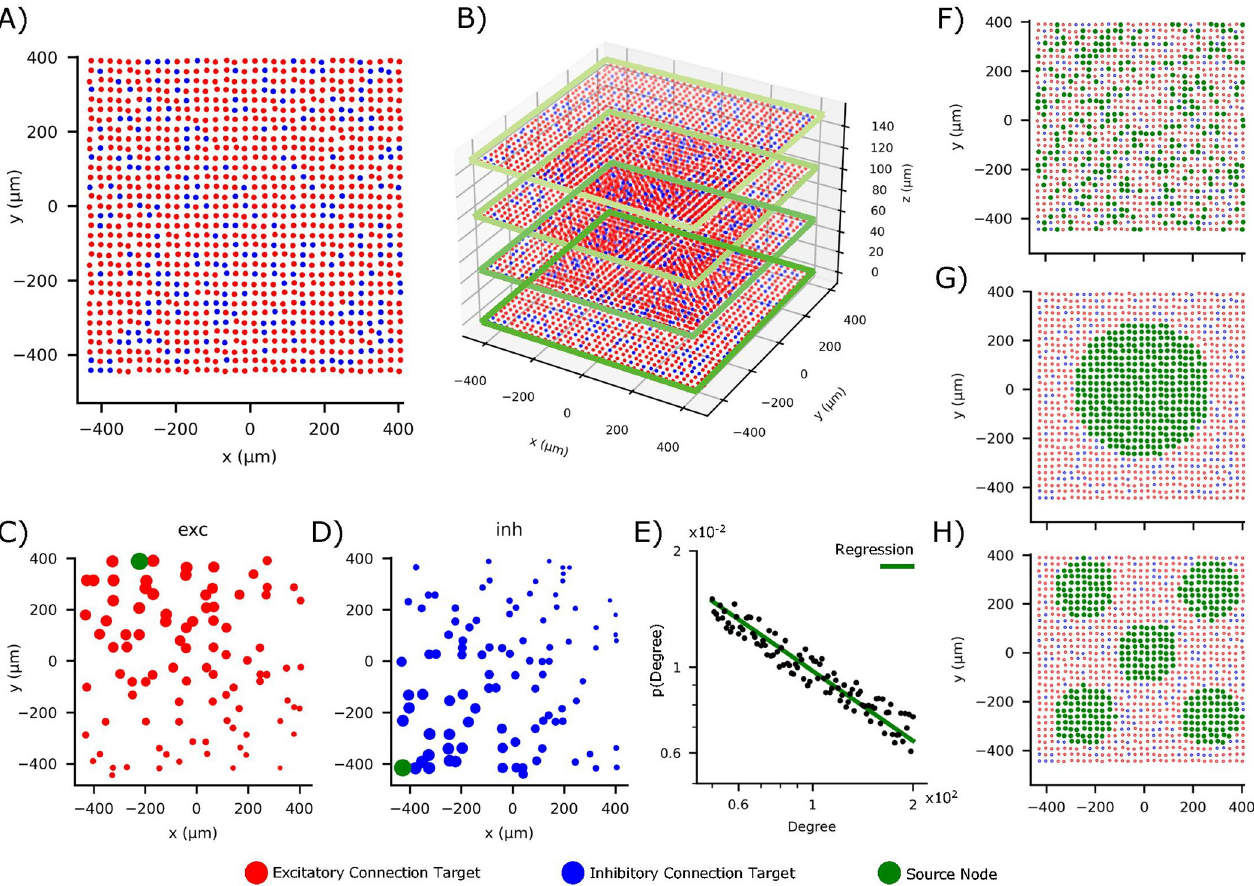
Fig 7. Topological properties of the simulated neuronal networks. ( A ) Neurons position in a 2D layer. Excitatory ( red ) and inhibitory ( blue ) neurons are randomly arranged on a surface of 0.7 mm 2 , defining the fundamental unit of the network. ( B ) Dense and compact 3D networks obtained by piling up different layers (only 4 in this sketch, for the sake of clarity) organized as in ( A ) on the 3D space. ( C-D ) Spatial distributions of the synaptic connections for excitatory ( red ) and inhibitory ( blue ) links in each layer. Considering a source neuron labeled in green, it projects connections whose efficacy (size of the colored target neurons) decreases as a function of the distance in according to Eq (3). ( E ) Degree distribution of the scale-free network showing a power-law with characteristic exponent equal to -0.61, in accordance with [19]. The distribution was implemented either only in the readout layer, in all the layers or in none of them. The connectivity among the layers was modeled according to different possible configurations depicted in the panels ( F-H ). In particular ( F ) shows a random positioning of the source neurons that project synaptic connections to the other (up or down) layers ( G 3 D ). In ( G-H ), the source neurons for the inter- rnd layer connections are arranged in a single central area of the plane ( G , G 3 D ) or distributed among five smaller confined areas ( H, G 3 D ). The number of links is 5 C C kept constant in the three configurations to allow significant comparisons.